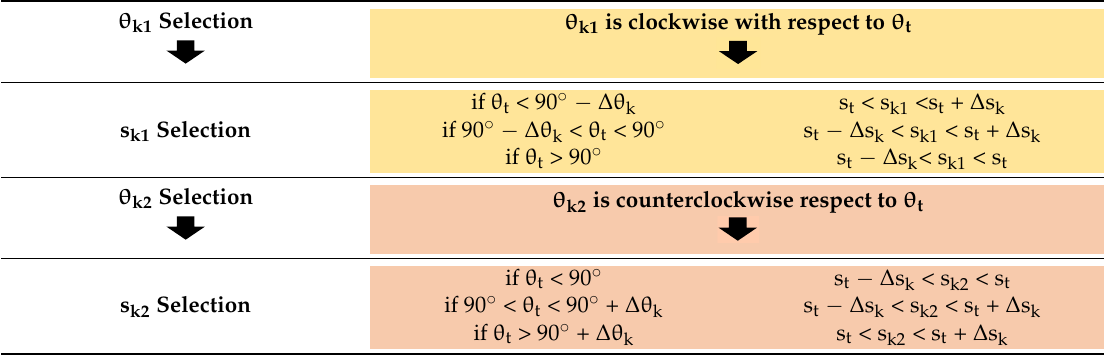
Figure 2. Angular search logic for narrow-V wakes and Kelvin arms.